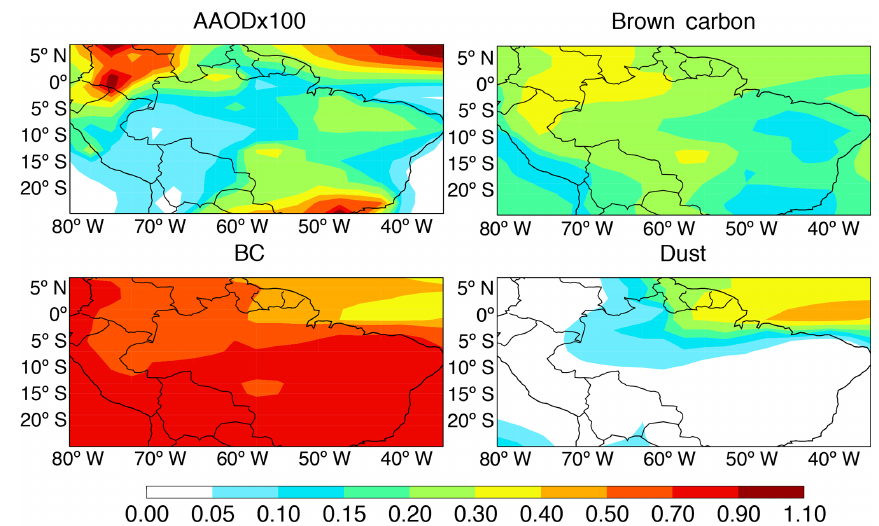
Figure 14. Model AAOD at 550nm (left top) and the contribution to total AAOD from BC, brown carbon, and dust over the Amazon Basin averaged over January–April